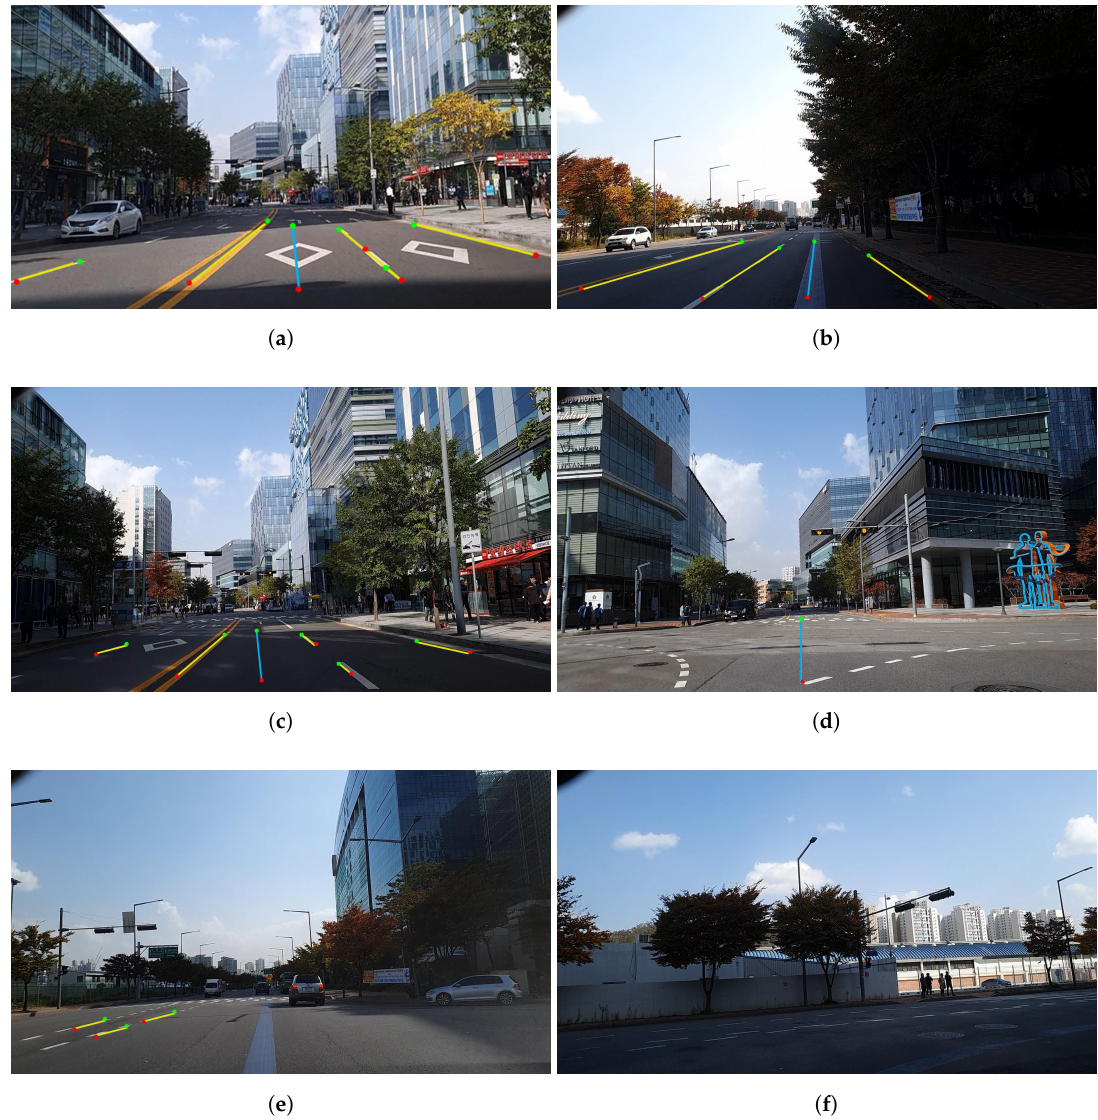
Figure 11. Results of driving link extraction in course 2: ( a , b ) correct detection of vehicle lines and extraction of driving link in the changes of illumination; ( c ) correct extraction of driving link by detecting yellow lane marking; ( d ) update previous driving link; ( e , f ) extraction